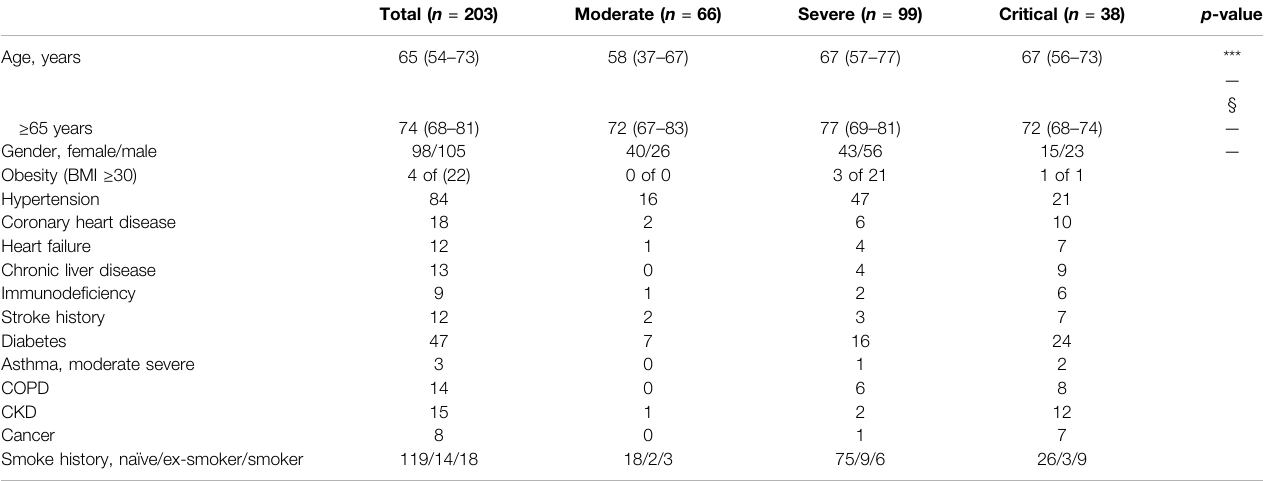
TABLE 1 | Statistical characteristics of baseline indicators in patients with